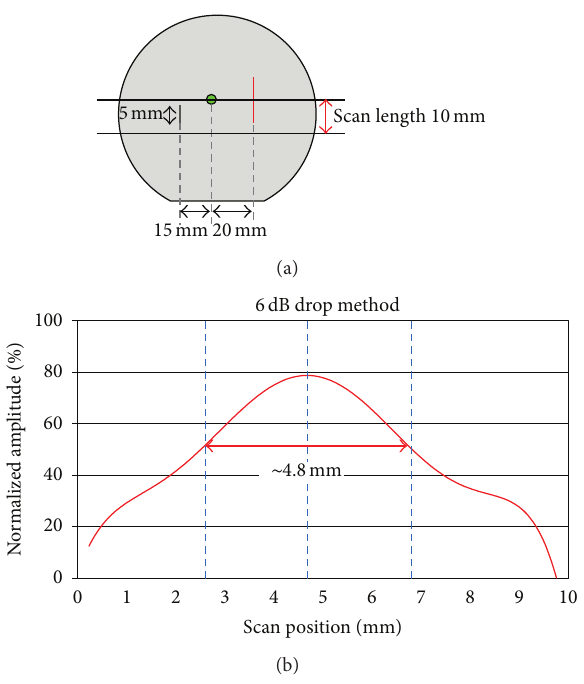
Figure 10: (a) Scan length and (b) experimental result by 6 dB drop